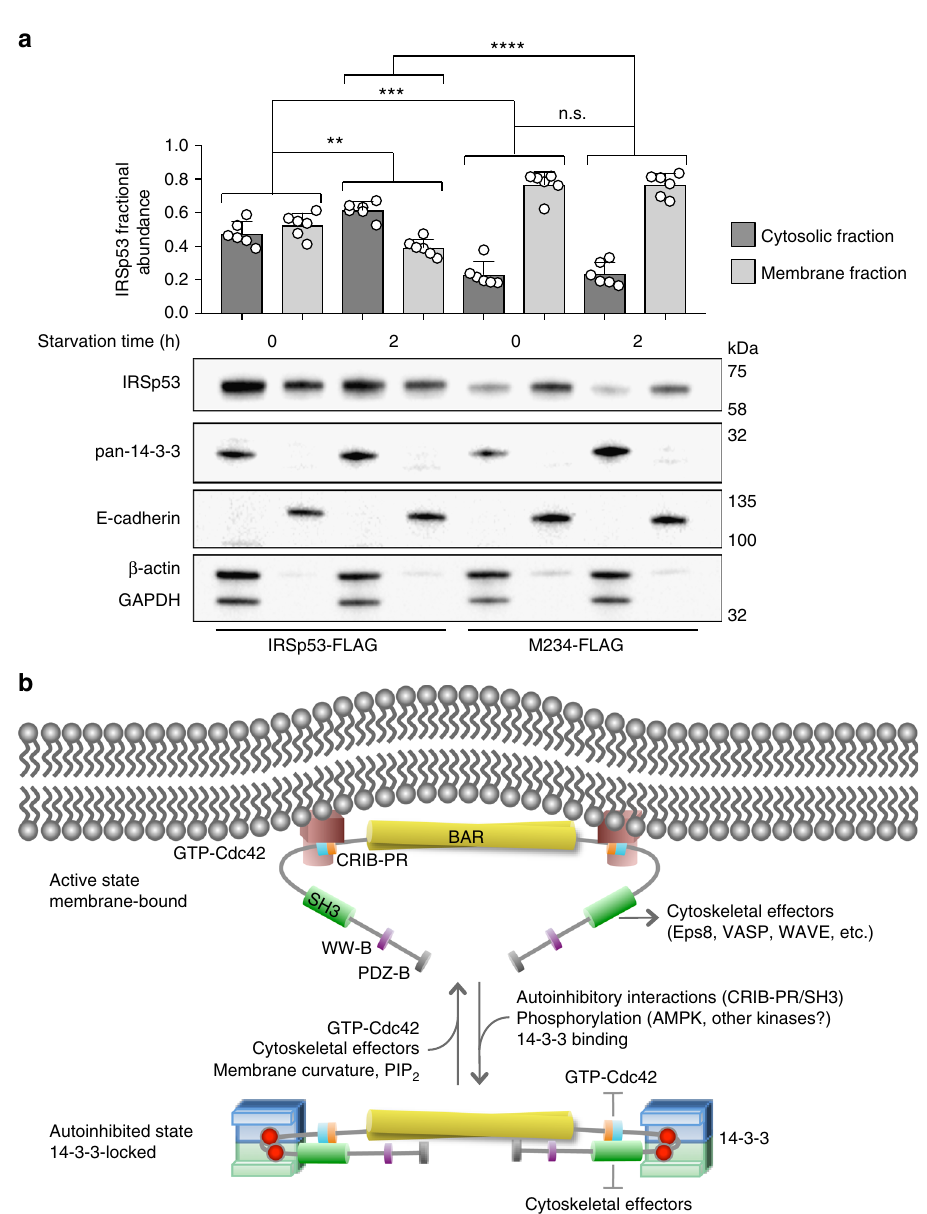
Fig. 6 Mechanism of IRSp53 regulation by 14-3-3. a 14-3-3 inhibits membrane binding of pIRSp53. The relative abundances of WT IRSp53-FLAG and mutant M234-FLAG in the cytosolic (black bars) and membrane fractions (gray bars) of fed and serum-starved HEK293T cells, were determined by weighting the abundance of IRSp53 or M234 against the combined abundance of GAPDH and β -actin, for the cytosolic fraction, or E-cadherin, for the membrane fraction. Error bars are ± s.d. from three different transfections and two experiments per transfection (shown as open circles). The statistical signi fi cance of the measurements was determined using an unpaired two-sided Student ’ s t -test (n.s., non-signi fi cant; ** p < 0.01; *** p < 0.001; **** p < 0.0001). b Model of IRSp53 activation and phosphorylation-dependent inhibition by 14-3-3. IRSp53 is activated by the binding of Cdc42 to the CRIB-PR domain and/or cytoskeletal effectors to the SH3 domain. Activation exposes the I-BAR domain for binding to the plasma membrane. Phosphorylation of IRSp53 and subsequent binding of 14-3-3 to phosphorylation sites located between the CRIB-PR and SH3 domains stabilizes the autoinhibited conformation and inhibits the binding of Cdc42 and downstream cytoskeletal